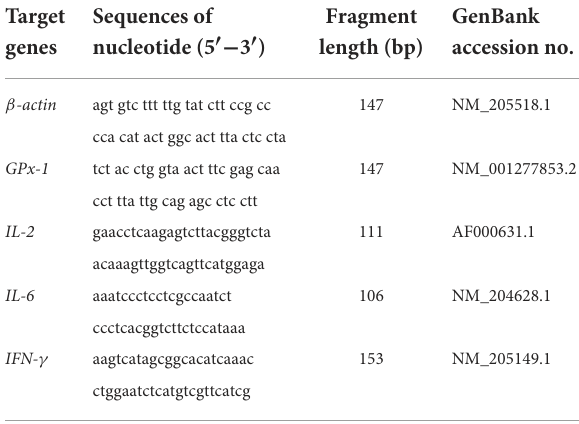
TABLE 2 Primers used for quantitative real-time PCR